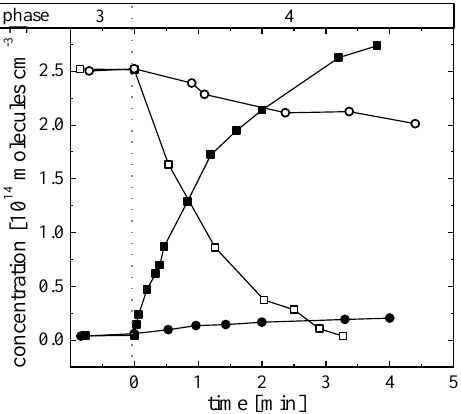
Figure 7. Photo-catalytic decomposition (i) of CO ( ○ ) and formation of CO 2 (●) in phases 3 and 4 after an Ar plasma pre-treatment in phase 1 and (ii) decomposition of CO ( □ ) and formation of CO 2 ( ■ ) after an O 2 plasma pre-treatment in phase 1 (Ar RF plasma: p = 0.26 mbar, φ = 14 sccm, t = 40 min, O 2 RF plasma: p = 0.53 mbar, φ = 14 sccm, t = 30 min, initial gas mixture: 1% CO in Ar, p = 1.3 mbar, UV light exposure in phase 4) [51], © IOP Publishing. Reproduced with permission. All rights reserved.